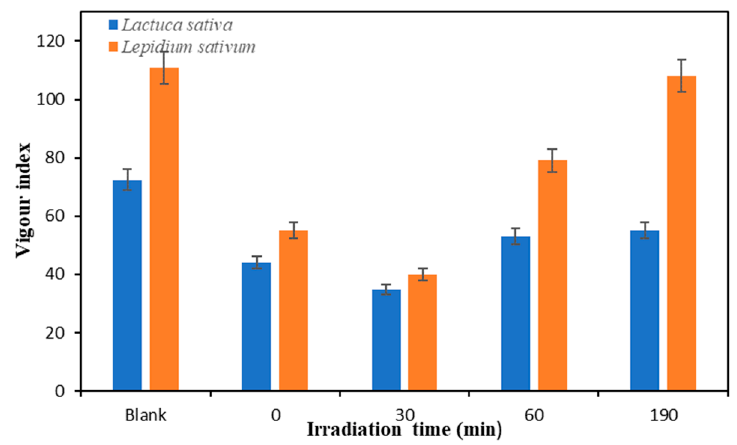
Figure 11. Evolution of the vigor index during the photocatalytic treatment of clofibric acid (30 mg/L of pollutant, 1 g/L of catalyst, 9.52 mW/cm 2 , 26 ± 2 °C).